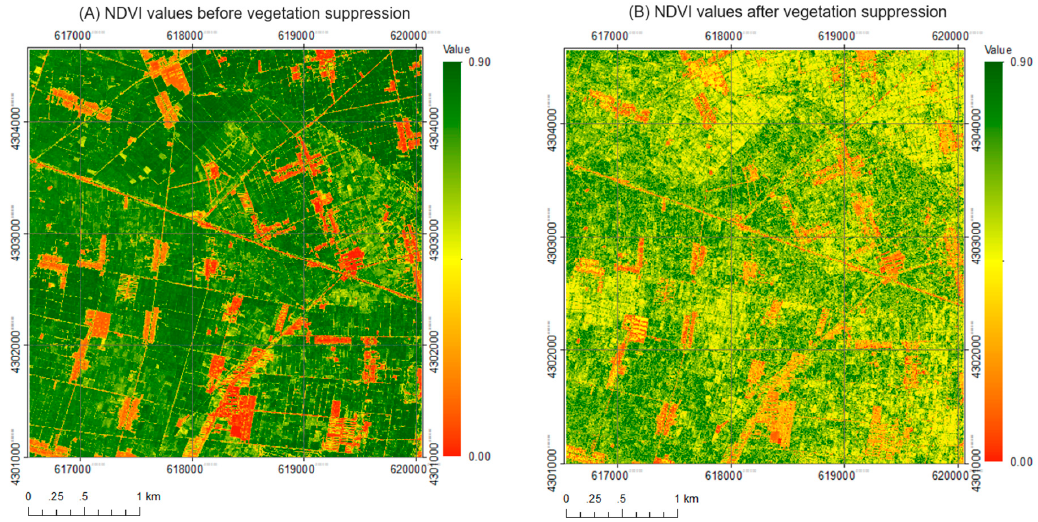
Figure 6. Comparison of NDVI values of airborne hyperspectral images before ( A ) and after vegetation suppression ( B ).